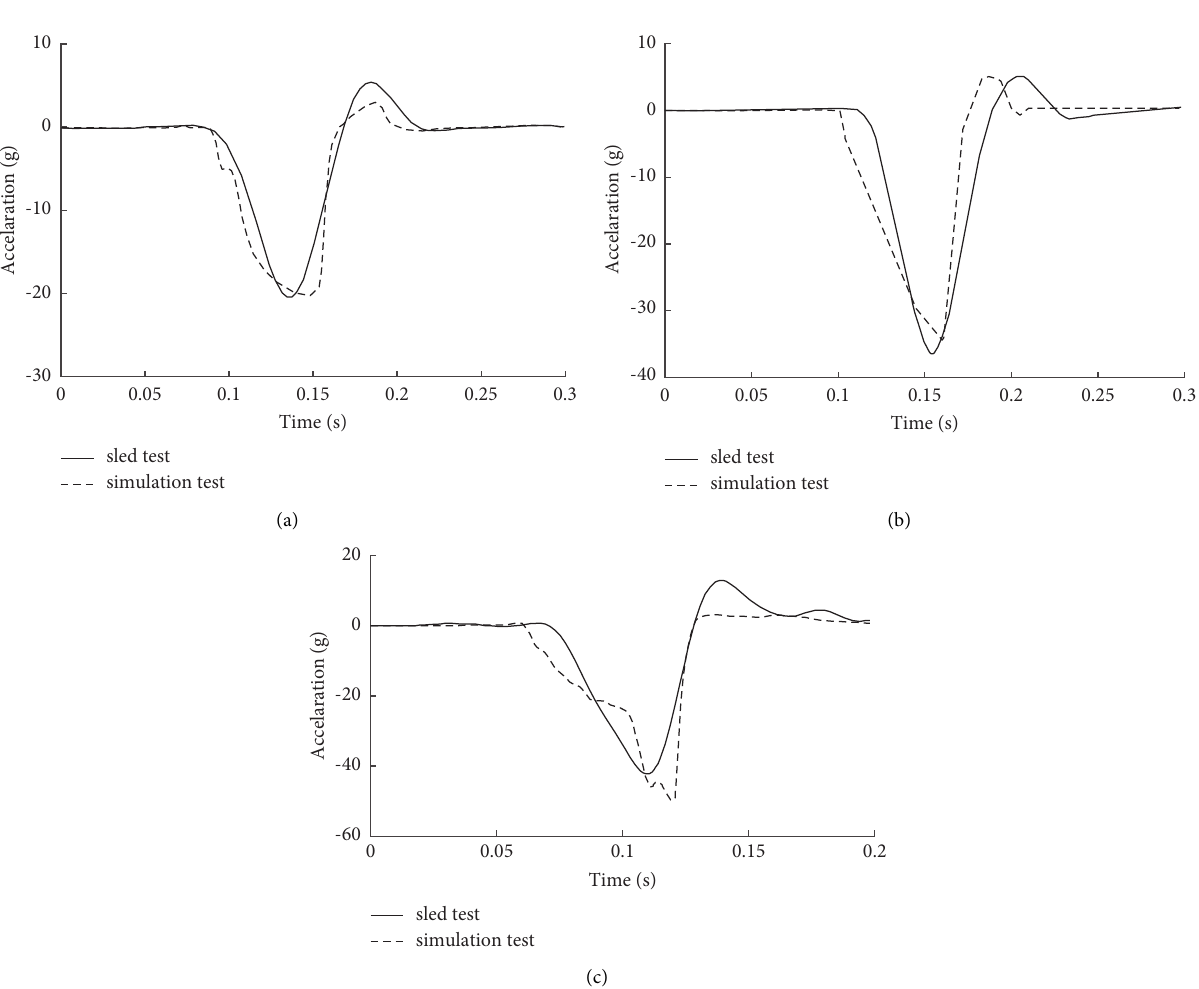
Figure 17: Collision acceleration curve.(a) Acceleration curve of the simulation and real sled crash test after filtering at 34km/h. (b) Acceleration curve of the simulation and real sled crash test after filtering at 50km/h. (c) Acceleration curve of the simulation and real sled crash test after filtering at